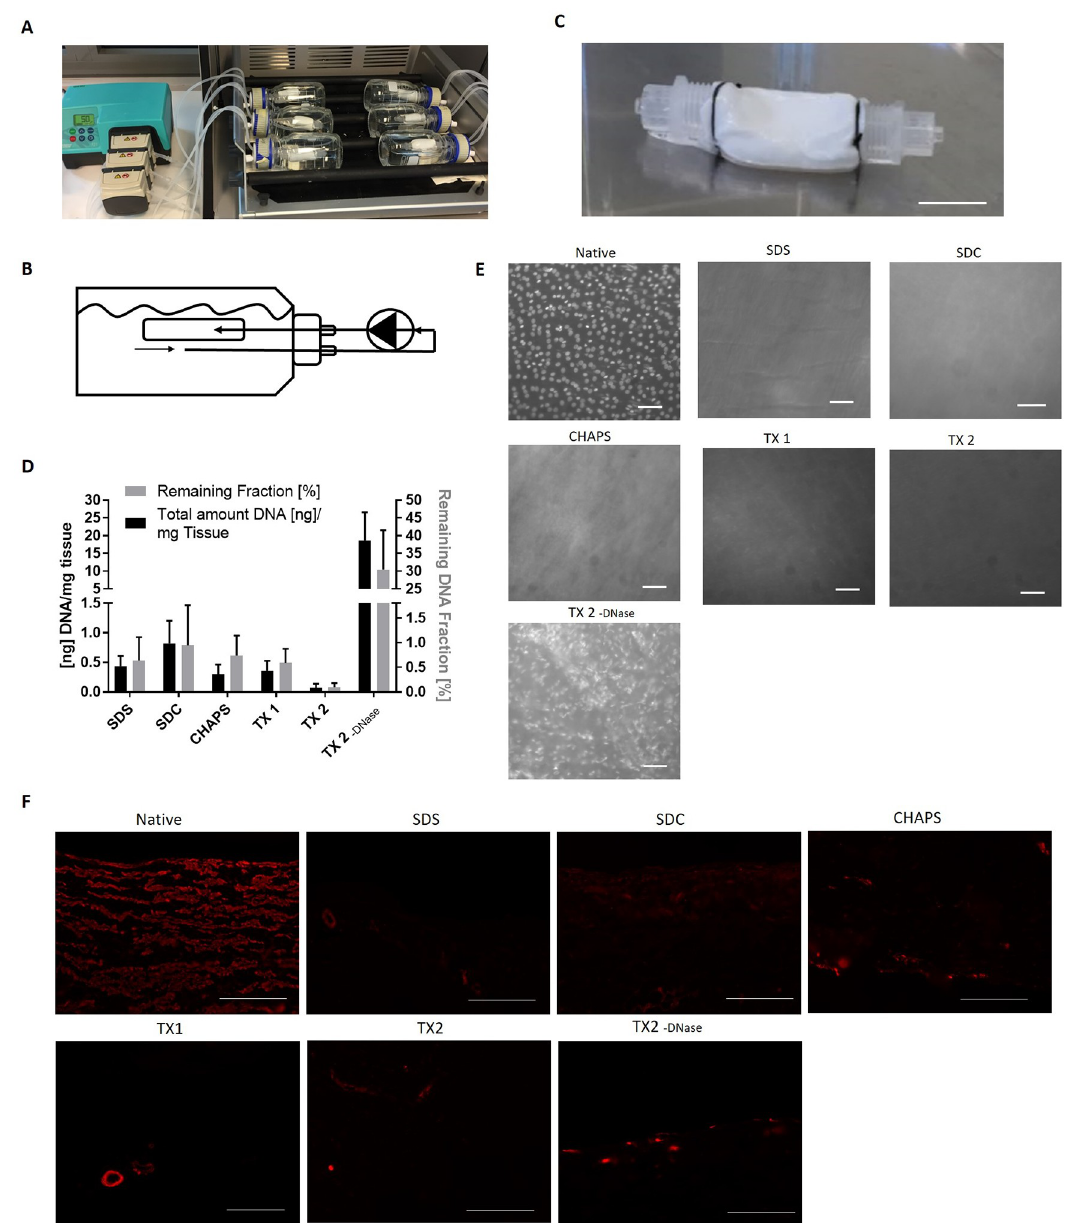
Fig 2. Decellularization efficacy. Porcine vena cava were decellularized according to the respective protocols and DNA content was measured. (A) Setup of the bioreactor, with vena cava inside 250mL flasks connected with tubing system to peristaltic pumps. (B) Schematic overview of perfusion through vena cava, allowing circulating liquid flow. (C) Illustrative picture of a decellularized vein connected to luers. Scale bar represents 2.5 cm. (D) DNA in the ECM was quantified and the result shown as ng DNA/mg tissue (left y-axis) and as % of remaining DNA compared to the DNA content of the same native blood vessel prior to decellularization (right y- axis) (100%, n = 4). Both Y-axes were divided into 2 sections to show small differences in the DC groups. (E) DAPI stained double- stranded DNA on the luminal side of ECM of the native blood vessel and the DC groups. Scale bar represents 50 μ m. (F) Staining of paraffin-embedded sections with anti-alpha smooth muscle actin. Scale bar represents 100 μ m.